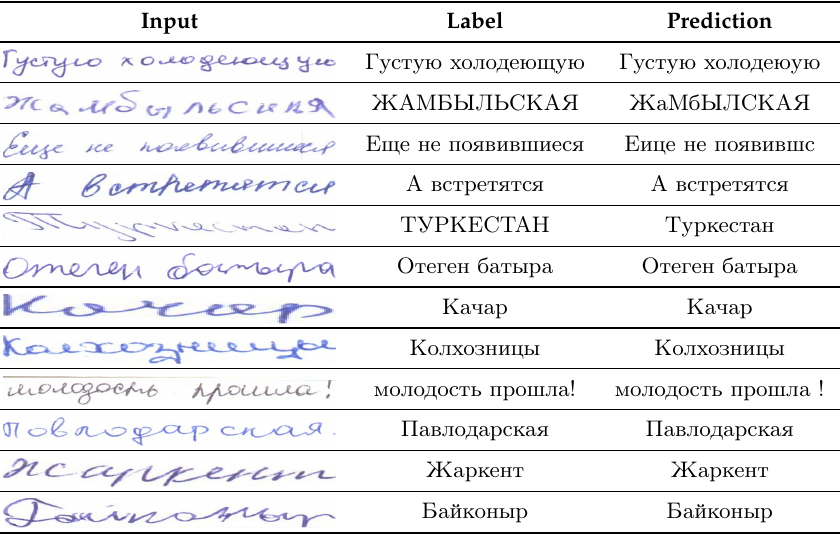
Table 2. Predictions obtained on the HKR dataset